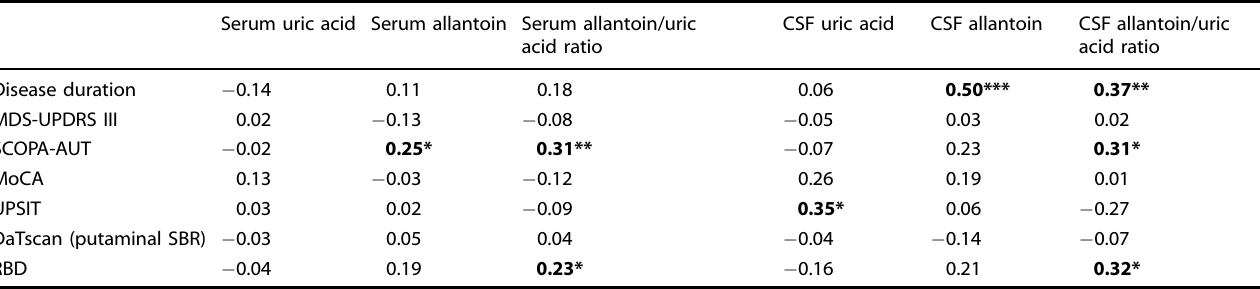
Table 2. Age and sex-adjusted partial correlations of biochemical and clinical parameters. Serum uric acid Serum allantoin Serum allantoin/uric acid